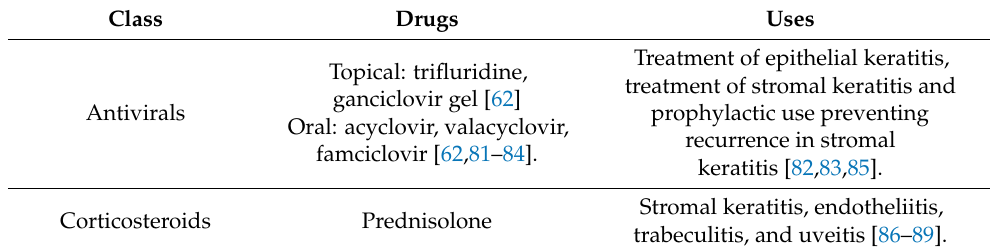
Table 2. Summary of current treatment for HSV